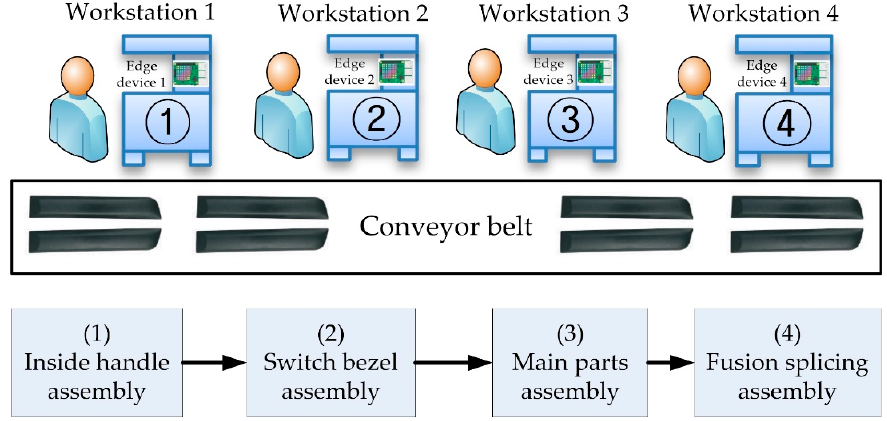
Figure 2. Example assembly line excerpt with edge devices attached to workstation panels.